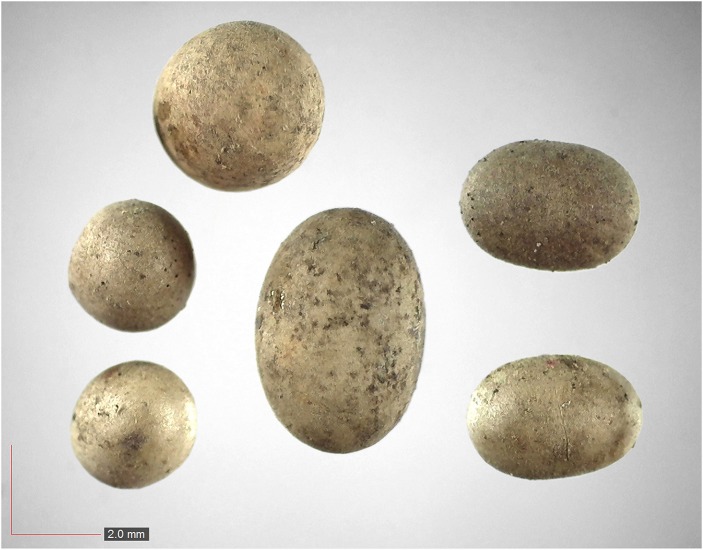
Unidentified 1.Table 2.